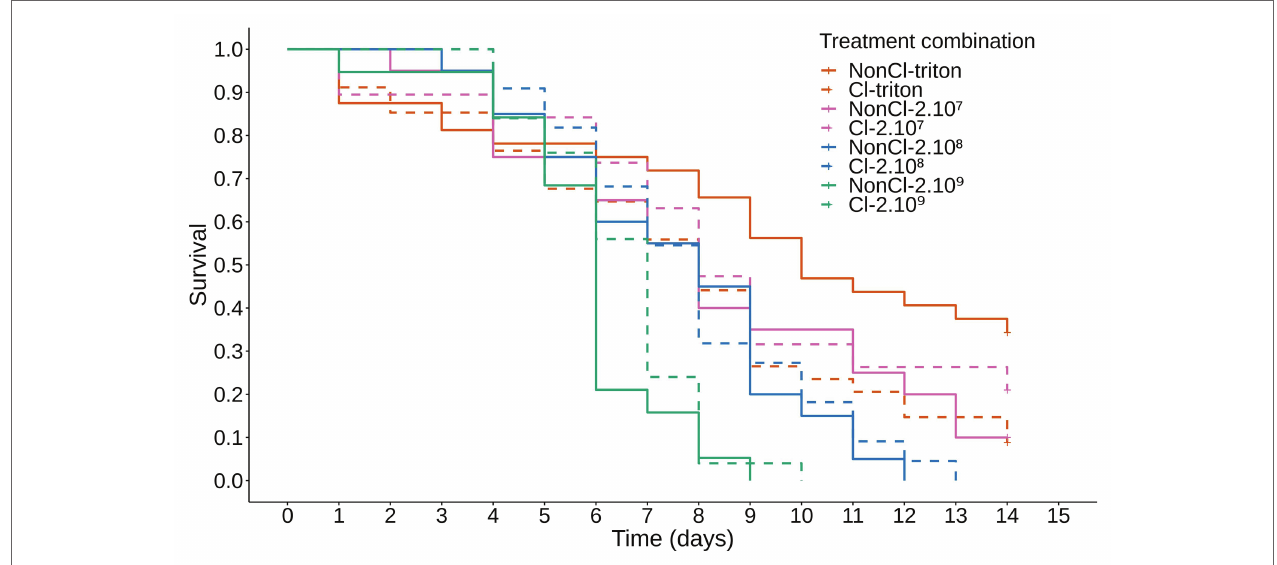
FIGURE 1 | Survival of Athalia rosae adults inoculated with Beauveria bassiana and depending on clerodanoid exposure. Kaplan-Meier curve showing the proportion of live individuals over 14 days of A. rosae adults inoculated with several concentrations of conidia of B. bassiana strain KVL 03-122. Orange lines: 0.05% Triton X-PBS (triton); pink lines: 2.10 7 ; blue lines: 2.10 8 ; green lines: 2.19 9 conidial/ml. Dashed lines represent adults allowed to take up clerodanoids (Cl) from a leaf of Ajuga reptans prior to inoculation (NonCl); survival of adults treated with Cl-triton was significantly different from those of the NonCl-triton treatment. There was no difference between survival of Cl and NonCl individuals in the other inoculation treatments with different concentrations of B. bassiana . Survival decreased with increasing concentrations of the inoculation treatment. See Supplementary Table S3 for post hoc comparisons.